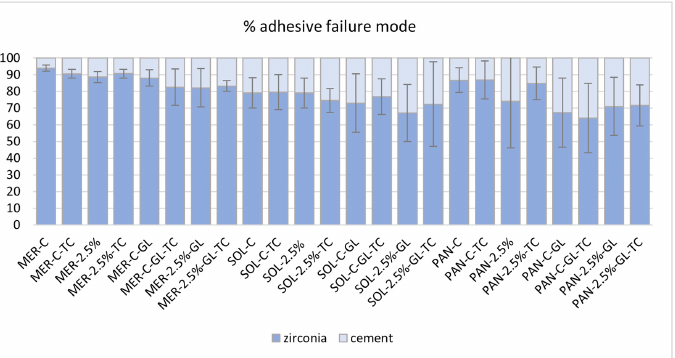
Figure 4. Adhesive failure mode (ADFM %) as calculated from stereoscope images using image analysis software. MER − C = Meron plus QM Control, MER − C − TC = Meron plus QM Control after thermal cycling, MER 2.5% = Meron plus QM with 2.5% zirconia NPs, MER 2.5% − TC = Meron plus QM with 2.5% zirconia NPs after thermal cycling, MER − C − GL = Meron plus QM Control after Gluma application, MER − C − GL − TC = Meron plus QM Control after Gluma application and thermal cycling, MER 2.5% − GL = Meron plus QM with 2.5% zirconia NPs after Gluma application, MER 2.5% − GL − TC = Meron plus QM with 2.5% zirconia NPs after Gluma application and thermal cycling, SOL − C = Solocem Control, SOL − C − TC = Solocem Control after thermal cycling, SOL 2.5% = Solocem with 2.5% zirconia NPs, SOL 2.5% − TC= Solocem with 2.5% zirconia NPs after ther- mal cycling, SOL − C − GL = Solocem Control after Gluma application, SOL − C − GL − TC = Solocem Control after Gluma application and thermal cycling, SOL 2.5% − GL = Solocem with 2.5% zirconia NPs after Gluma application, SOL 2.5% − GL − TC = Solocem with 2.5% zirconia NPs after Gluma ap- plication and thermal cycling, PAN − C = Panavia SA Universal Control, PAN − C − TC = Panavia SA Universal Control after thermal cycling, PAN 2.5% = Panavia SA Universal with 2.5% zir- conia NPs, PAN 2.5% − TC = Panavia SA Universal with 2.5% zirconia NPs after thermal cycling, PAN − C − GL = Panavia SA Universal Control after Gluma application, PAN − C − GL − TC = Panavia SA Universal Control after Gluma application and thermal cycling, PAN 2.5% − GL = Panavia SA Uni- versal with 2.5% zirconia NPs after Gluma application, PAN 2.5% − GL − TC = Panavia SA Universal with 2.5% zirconia NPs after Gluma application and thermal